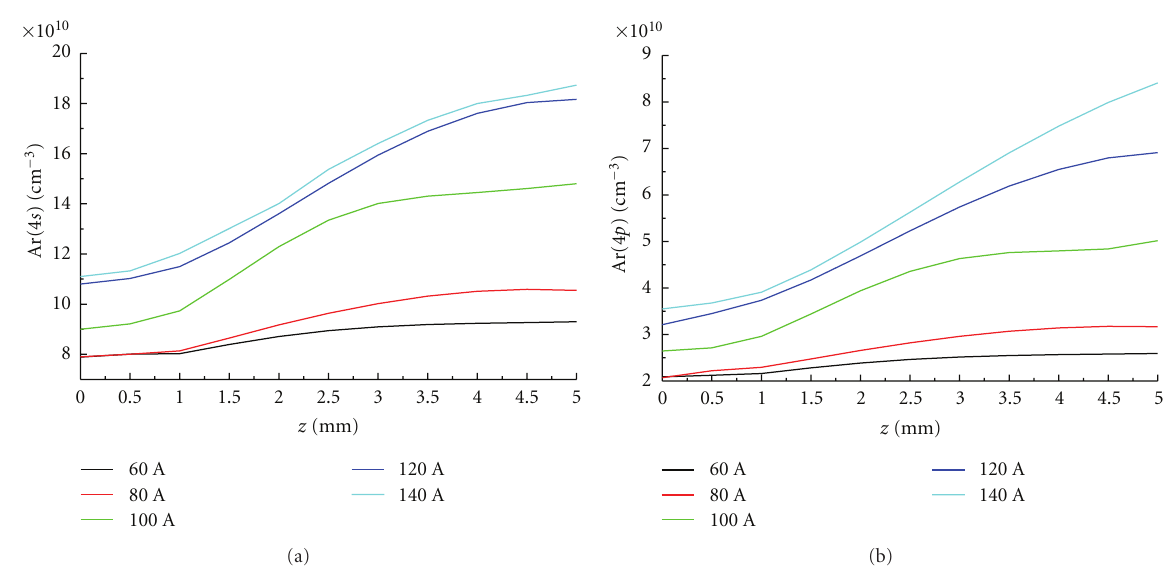
Figure 11: Populations along the throat axis of: (a) Ar(4 s ), (b) Ar(4 p